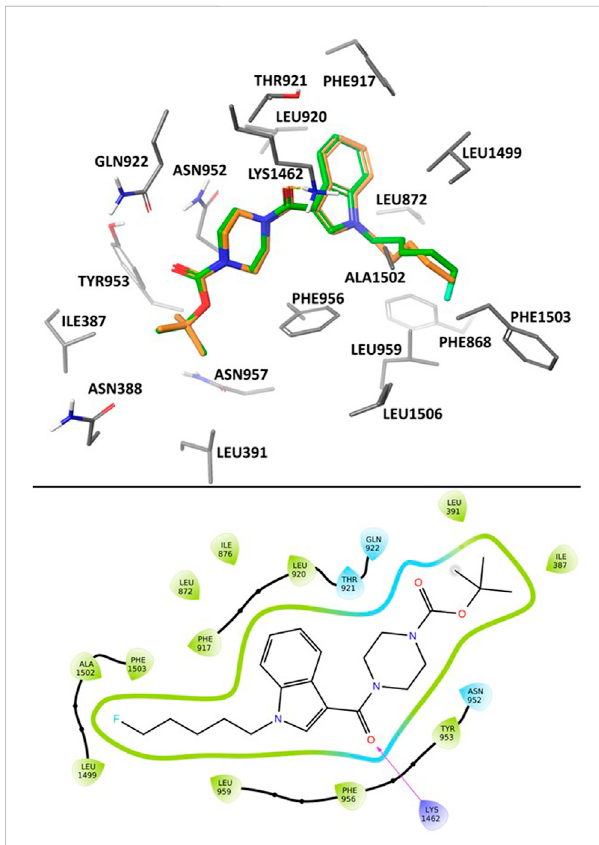
FIGURE 4 Calculated binding mode of SB2193 (orange) and SB2193F (green)atCa v 3.1(PDB:6KZP)(Zhaoetal.,2019)usingGlideXPDocking (Friesner et al., 2006) (top). 2D Ligand Interaction Diagram depicting the summarizing the interactions between SB2193F and the Ca v 3.1 binding site (bottom).